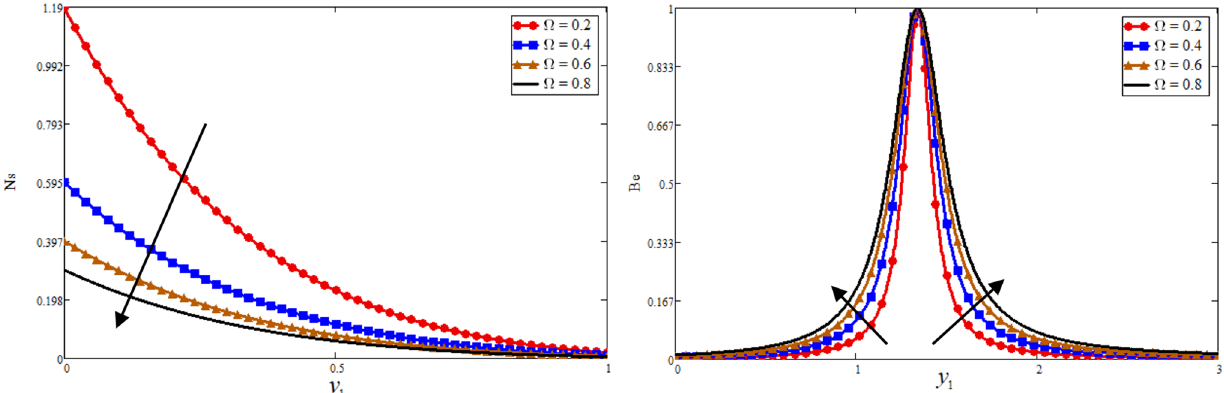
Figure 5. Effect of (cid:31) on Bejan number, and entropy generation.